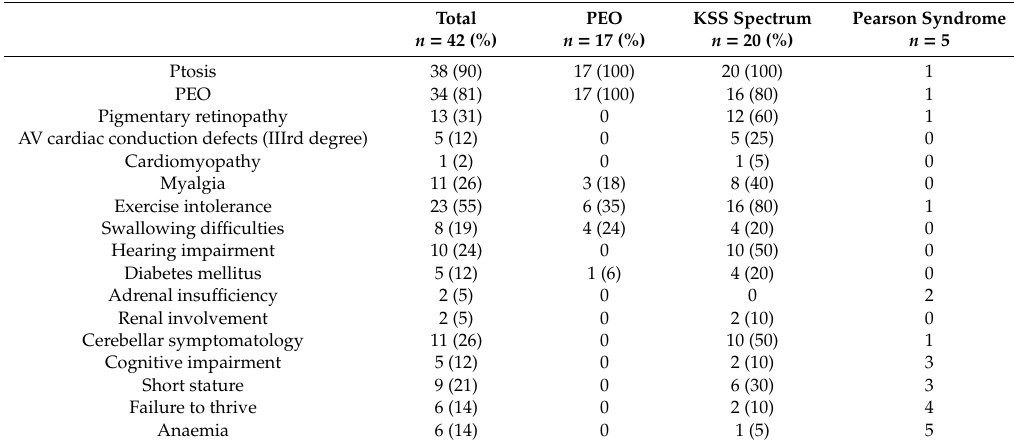
Table 2. Summary of clinical features of 42